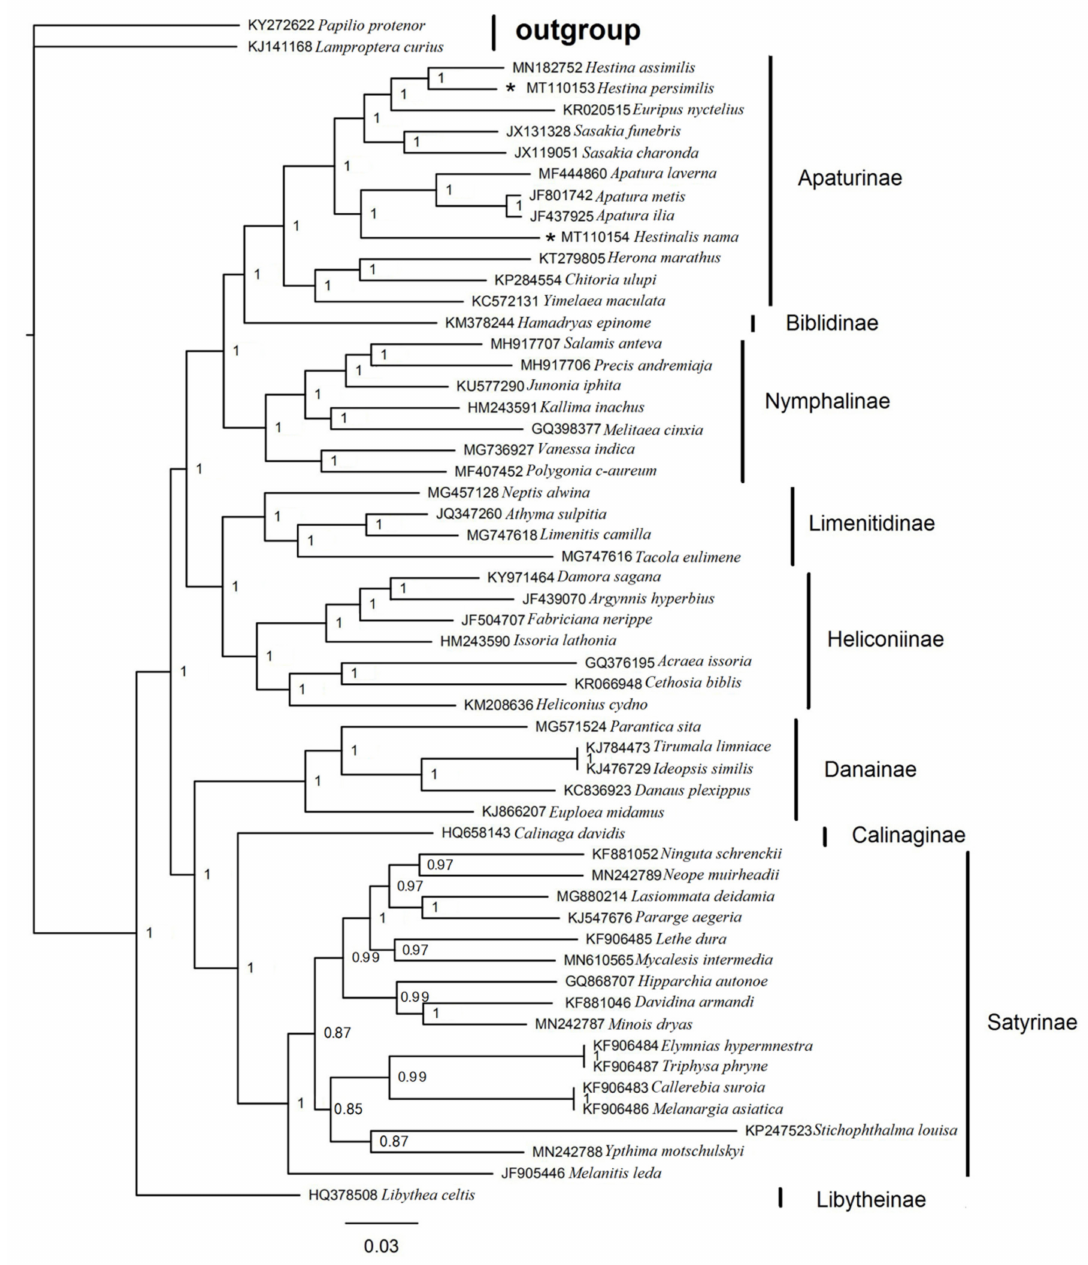
Figure 11. Inferred phylogenetic relationships among Lepidoptera based on the concatenated nucleotide sequences of 13 PCGs using BI. Numbers on branches are Bayesian posterior probabilities. Papilio protenor (KY272622) and Lamproptera curius (KJ141168) are used as